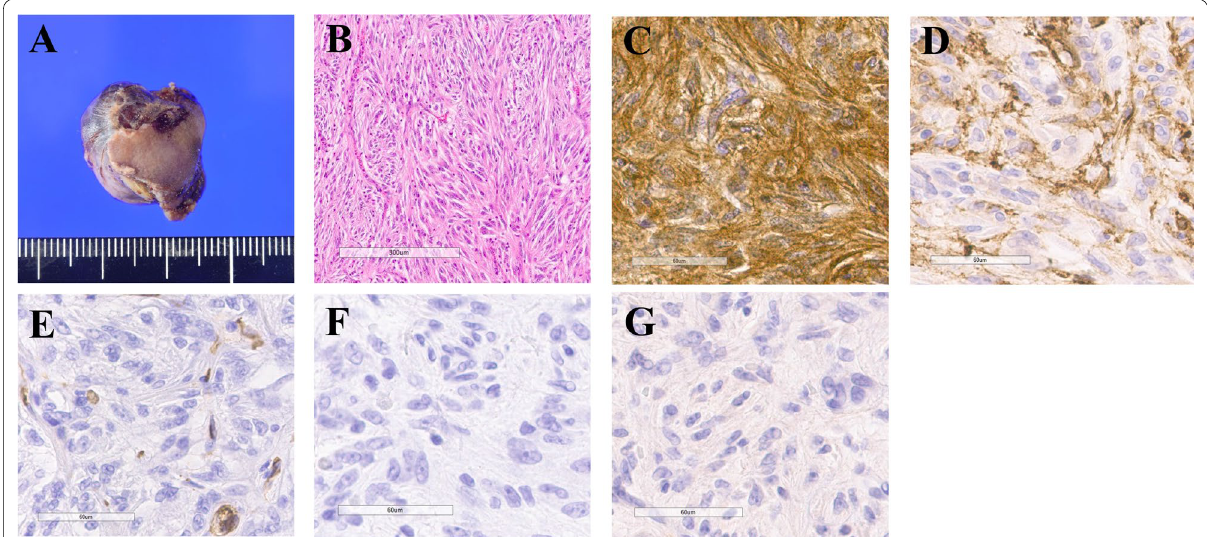
Fig. 3 A Gross inspection of the specimen showed a firm white tumor measuring 16 tumor was composed of spindle cells with a mitotic count of 4 per 50 high-power fields. Immunochemical analysis revealed positive tumor staining for C c-kit protein and D alpha-smooth muscle actin and negative staining for E CD34, F desmin, and G S-100 protein